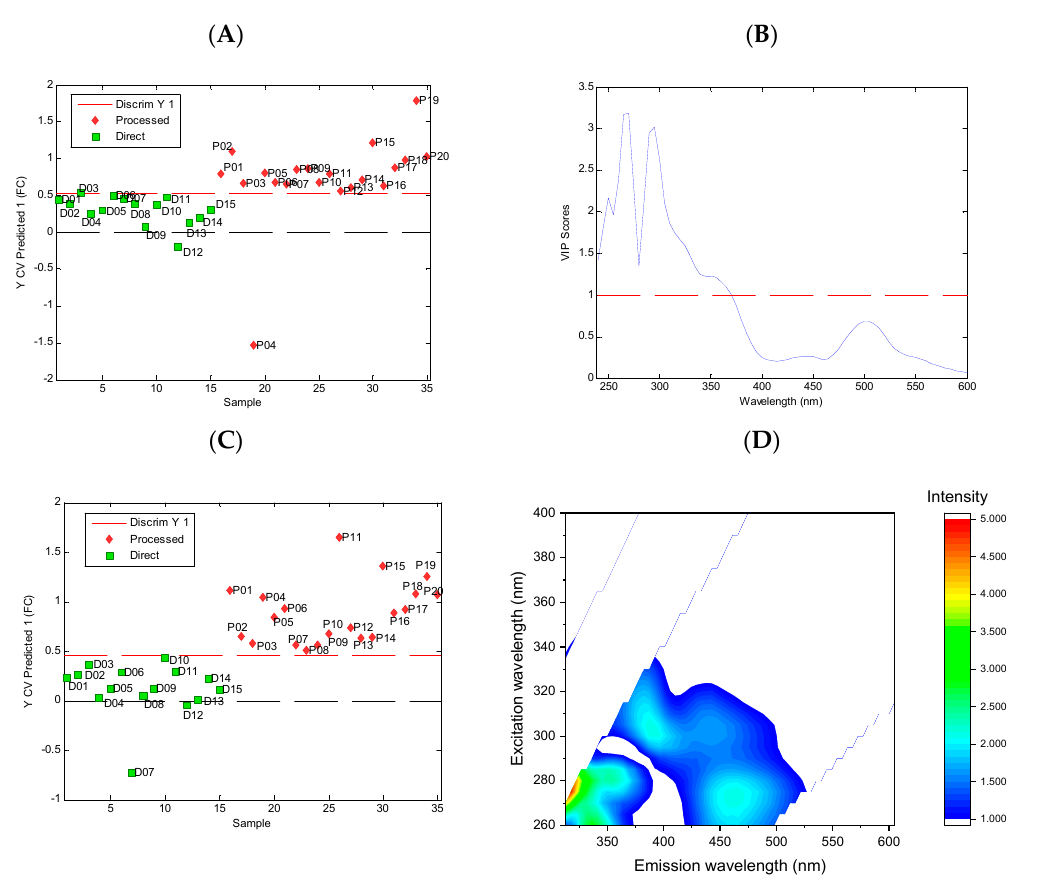
Figure 6. Classification models for direct and processed strawberry juice obtained using PLS-DA method. Models based on UV–vis absorption spectra: classification results ( A ) and variable importance in projection (VIP) plot ( B ). Model based on uEEMs: classification results ( C ) and refolded variable importance in projection (VIP) plot ( D ). Table 2. Performance of classification models for direct and processed strawberry beverages devel- oped using absorption and fluorescence